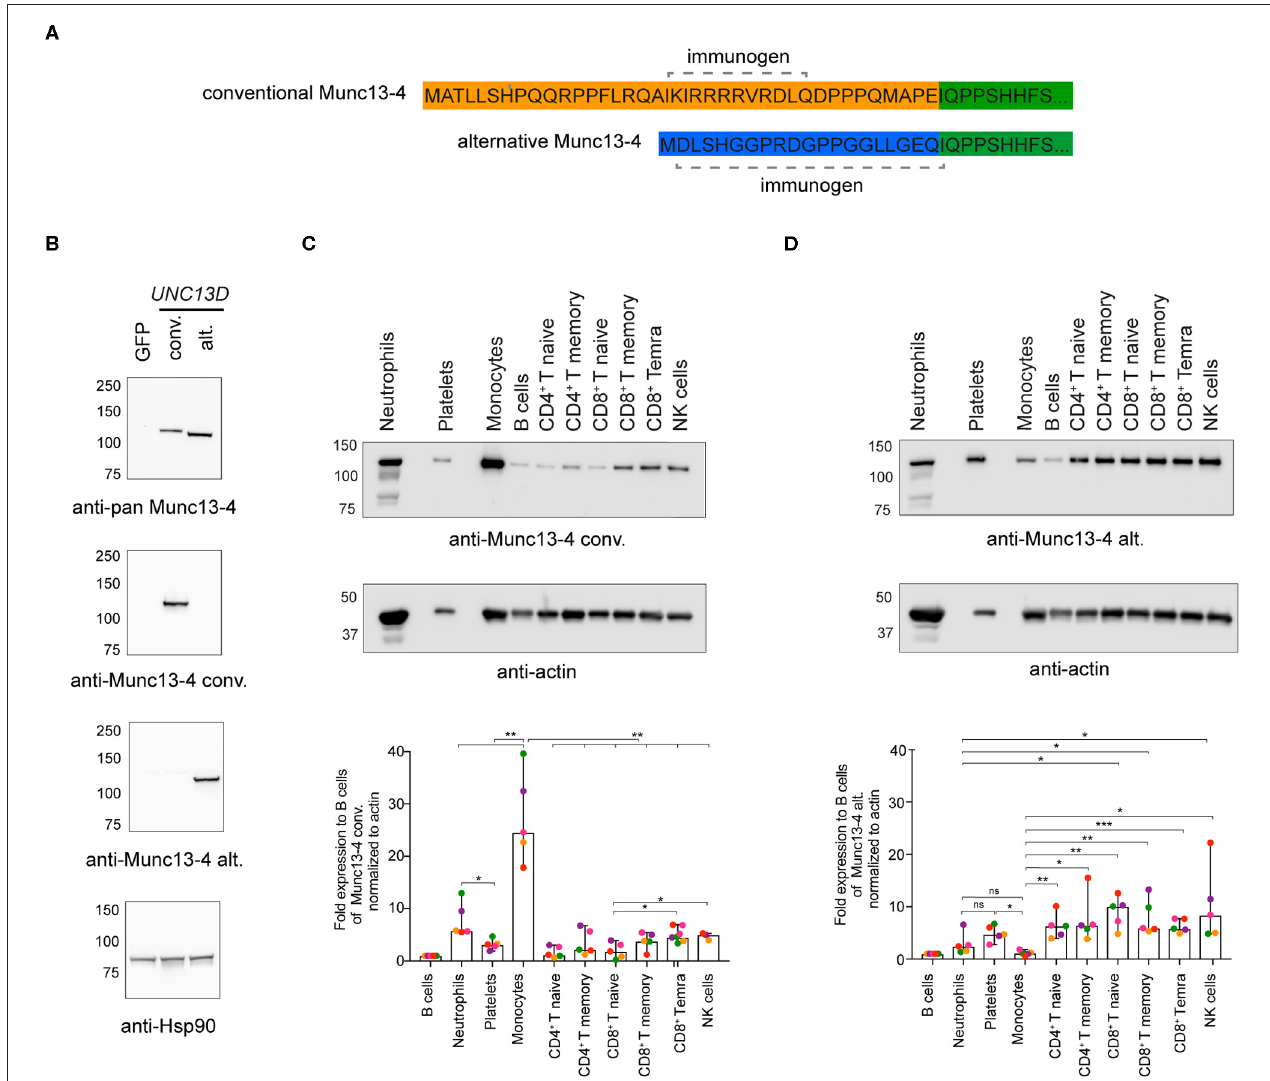
FIGURE 2 | Munc13-4 isoform expression in different human hematopoietic cells. (A) Recombinant monoclonal rabbit IgG antibodies were generated against peptides unique to the N-termini of human conventional (conv) or alternative (alt) Munc13-4 isoforms. (B) Western blot analysis of whole cell lysates from HEK-293T cells expressing human conventional or alternative Munc13-4. HEK-293T cells, which do not endogenously express Munc13-4, were transiently transfected with plasmids encoding GFP, conventional Munc13-4, or alternative Munc13-4, as indicated. Munc13-4 isoform over-expression was detected using an anti-pan-Munc13-4 antibody, which recognizes a C-terminal epitope shared by both alternative and conventional Munc13-4, or antibodies specific to either isoform. Blotting for Hsp90 served as a loading control. (C,D) Western blot analysis of conventional (C) and alternative (D) Munc13-4 isoform expression using isoform-specific antibodies in platelets and neutrophils and monocytes, B cells, naïve and memory CD4 + T cells, naïve, memory and effector CD8 + T cells and NK cells freshly isolated and sorted from the peripheral blood of healthy donors. The blots shown are representative of five independent donors (different colors represent individual donors). The histograms show expression for the conventional and alternative Munc13-4 expression normalized to actin as fold change relative to B cells. Bars depict mean ± SD, whereas dots represent values for each donor. Data are from five healthy donors. P -values were calculated using RM-ANOVA. ns, non-significant, * P ≤ 0.05, ** P ≤ 0.01; *** P ≤ 0.001; N =